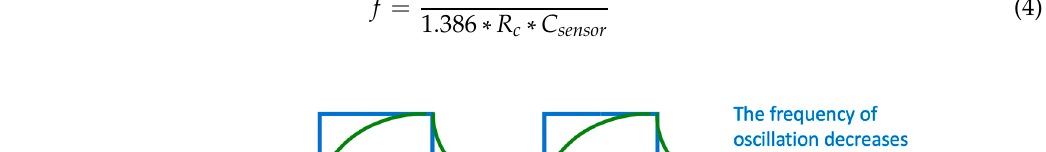
Table 2. Velocity (m/s) in SSC and CHSC from simulations.